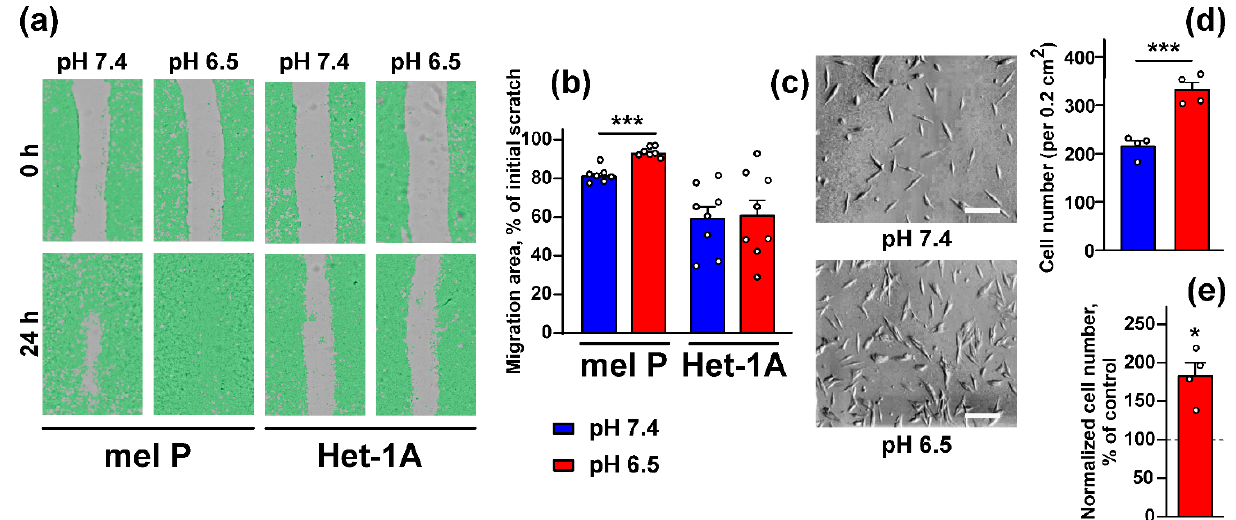
Figure 2. Influence of cell media acidification on mel P and Het-1A cell migration and invasion: ( a ) representative pictures of scratch test for mel P and Het-1A cells incubated at pH 7.4 and 6.5; ( b ) scratch square occupied by migrating mel P and Het-1A cells. Data are presented as % of the scratch surface, occupied by migrating cells ± SEM ( n = 7–8), *** ( p < 0.001) indicates significant difference between data groups by two-tailed t -test; ( c ) representative phase-contrast images showing mel P cells migrated through the 8 μ M pore bottom of the migration chamber upon cultivation at pH 7.4 and 6.5 ( × 100 magnification, scale bar = 20 μ m); ( d ) number of mel P cells migrated through the 8 µ M pore bottom of the migration chamber upon cultivation at pH 7.4 and6.5. Data presented as the number of cells per 0.2 cm 2 ± SEM ( n = 4). *** ( p < 0.001) indicates significant difference between data groups by two-tailed t -test; ( e ) number of migrated mel Pcells cultivated at pH 6.5 assayed by the WST-1 test and normalized to the number of migrated cells, cultivated at pH 7.4 (control, shown by dashed line). Data are normalized cell number ± SEM ( n = 4). * ( p < 0.05) indicates significant difference from the control by One-sample t -test.